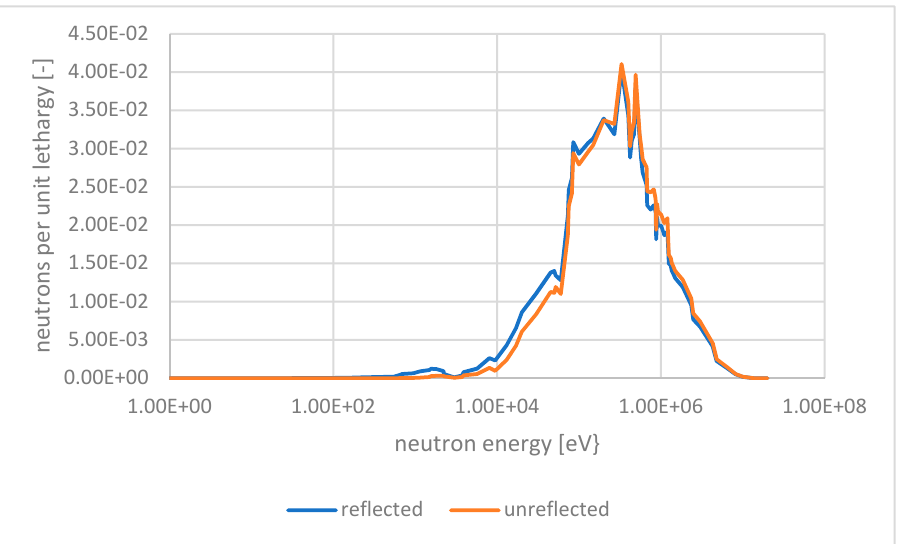
Figure 10. Neutron spectrum 20% enriched for the reflected and reflected eutectic system (calculated through POLARIS).